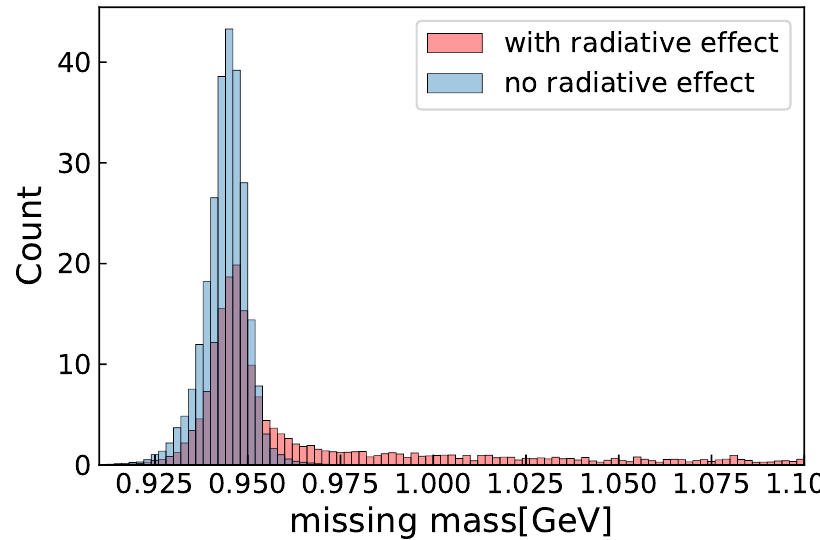
Figure 5. The missing mass from the Hall C simulation software (SIMC Monte Carlo package [55,56]) with (red) and without (blue) radiative effects at Q 2 = 14 (GeV/ c ) 2